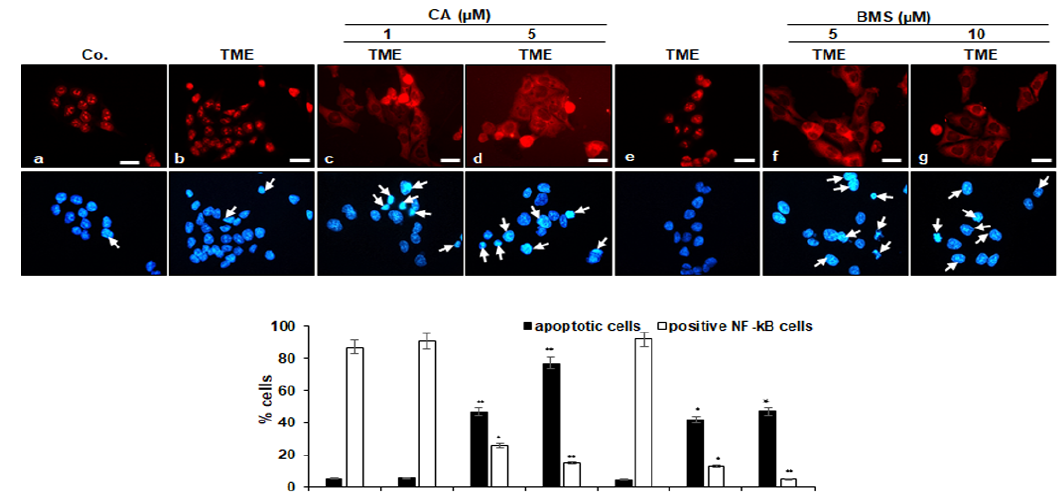
Figure 4. E ff ect of Calebin A (CA) or specific IKK inhibitor BMS-345541 on activation and nuclear translocation of p65-NF- κ B in CRC cells: Serum-starved HCT116 cells in a monolayer culture from multicellular pro-inflammatory TME cultures were treated as described in Materials and Methods, stained for p65 subunit of NF- κ B by immunofluorescence and counterstained with DAPI. Magnification 600 × ; scale bar = 30 mm. All experiments were performed at least in triplicate and quantification of positively labelled p65-NF- κ B-nuclei and apoptotic nuclei (white arrows) were performed by counting 600–800 cells from 20 di ff erent microscopic fields. Values were compared with the control and p < 0.05 (*), p < 0.01 (**) were considered statistically significant.